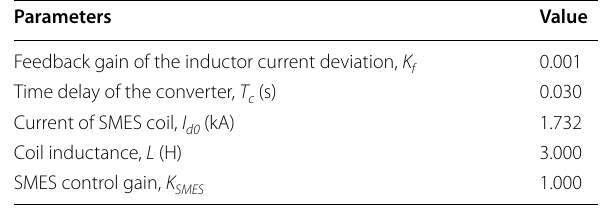
Table 3 Dynamic parameters of the SMES control loop